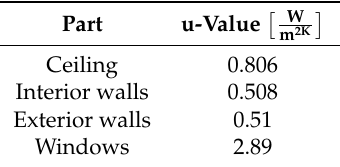
Table 2. Construction characteristics of the different parts of the